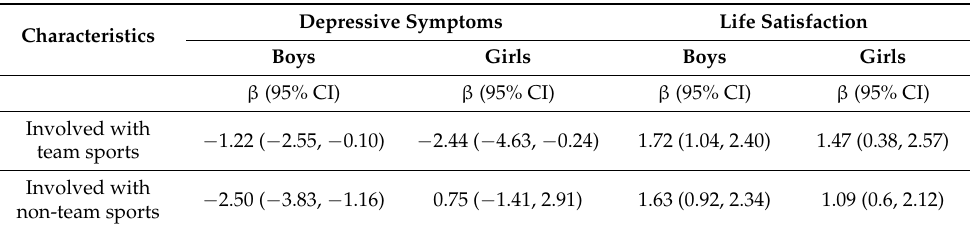
Table 1. Adjusted associations of sports participation with mental health indicators in adolescents in